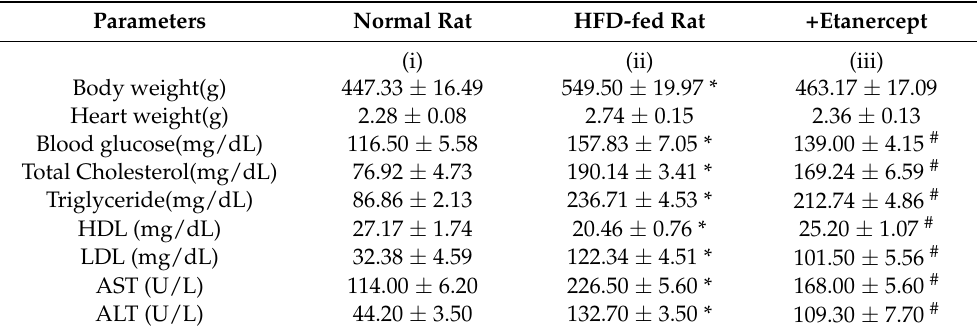
Table 1. Effects of etanercept on the changes in body weight, heart weight, blood glucose and lipid levels, and other parameters in high fat diet (HFD)-fed rats.